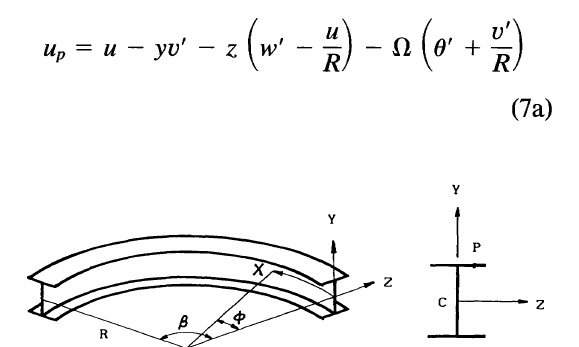
FIGURE 1 Cross-section of a curved thin-walled